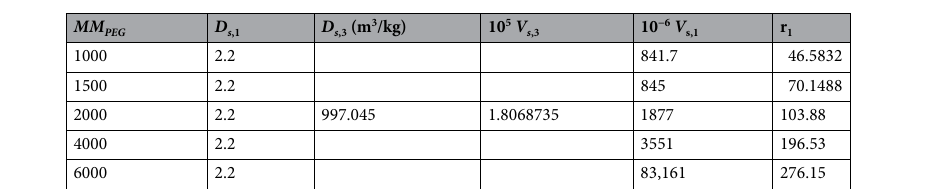
Table 7. Dielectric constant ( D s ) and molar volume ( V s ) of different molecular mass of PEG 1000,1500,2000,4000,6000 (1) and water (3) at desired temperature in modeling of the e-Wilson model. Dielectric constant (D s ) were given from Madelung et al. 49 , Also, Molar volume of PEG 1000 , 1500 were obtained from 50,51 , for PEG 2000,4000 were from 47 , and for PEG 6000 was from 52 . The molar volume of water was calculated from the equation presented by Robinson and Stocks 53 .